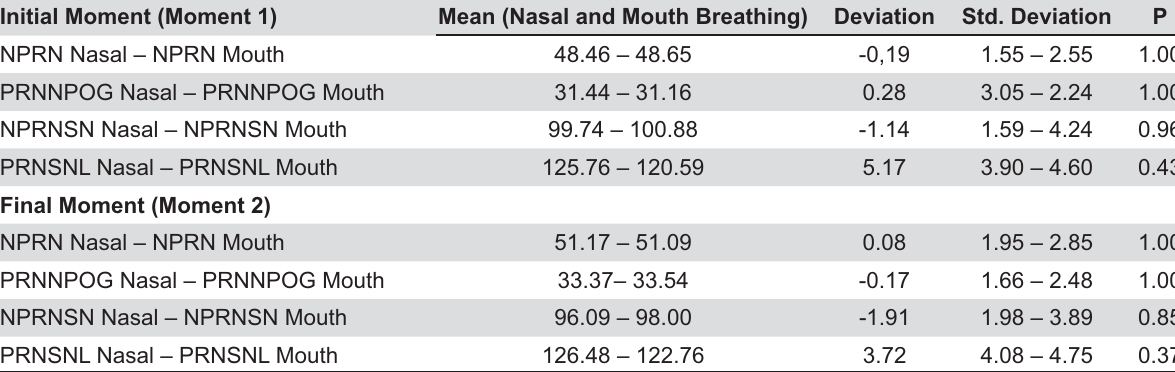
Note: * p<0.05 indicates statistically difference Table 6- Comparison between nose measurement in moments according to nasal and mouth